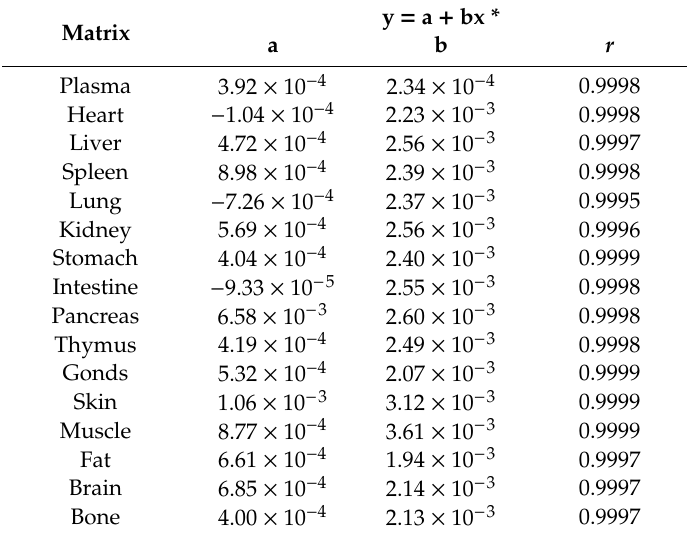
Table 1. The linearity equations of GC20 in rat plasma and rat tissue homogenates over a concentration range of 1–1000 ng / mL.